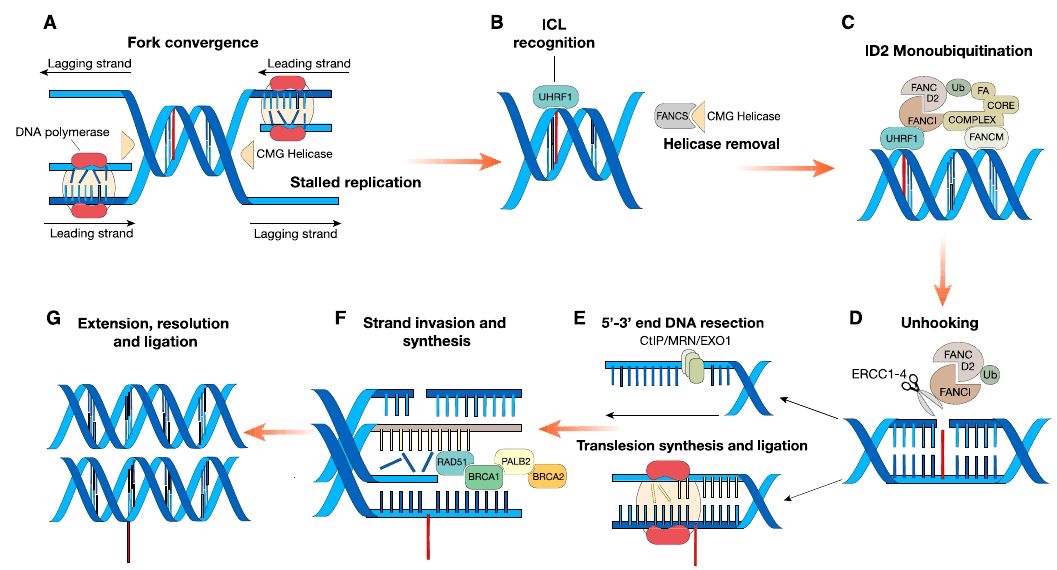
Figure 1. A combination of multiple DNA repair pathways promotes interstrand cross-link repair. ( A ) Converging replication forks stall in proximity of DNA lesion; ( B ) ICL identification by UHRF1. Concurrently, FANCS removes the CMG helicase complex that obstructs the replication fork site, making it available for the FA core complex. ( C ) As a consequence, both the core complex and the FANCD2-FANCI heterodimer are recruited and the FANCD2-FANCI complex is monoubiquitinated by the E3 ligase FANCL and its partner, the E2 ligase UBE2T (both members of the FA core complex). ( D ) When ubiquitinated, the ID2 complex promotes the activity of multiple factors such as ERCC1, ERCC4, and SLX4, which coordinate the nucleotide excision responsible for the unhooking. ( E ) At this stage, the two strands have diverging fates: the one that underwent the incision is further processed by nucleases such as CtBP-interacting protein (CtIP), MRN (MRE11–RAD50–NBS1), or exonuclease 1 (EXO1); on the other strand, translation synthesis polymerases bypass the lesion and provide the complementary filament. ( F ) Next, the ssDNA overhang acts as a template for the homologous recombination mediated by RAD51 / BRCA2 / PALB2 / BRCA1 proteins. ( G ) Eventually, after extension and ligation, DNA damage is